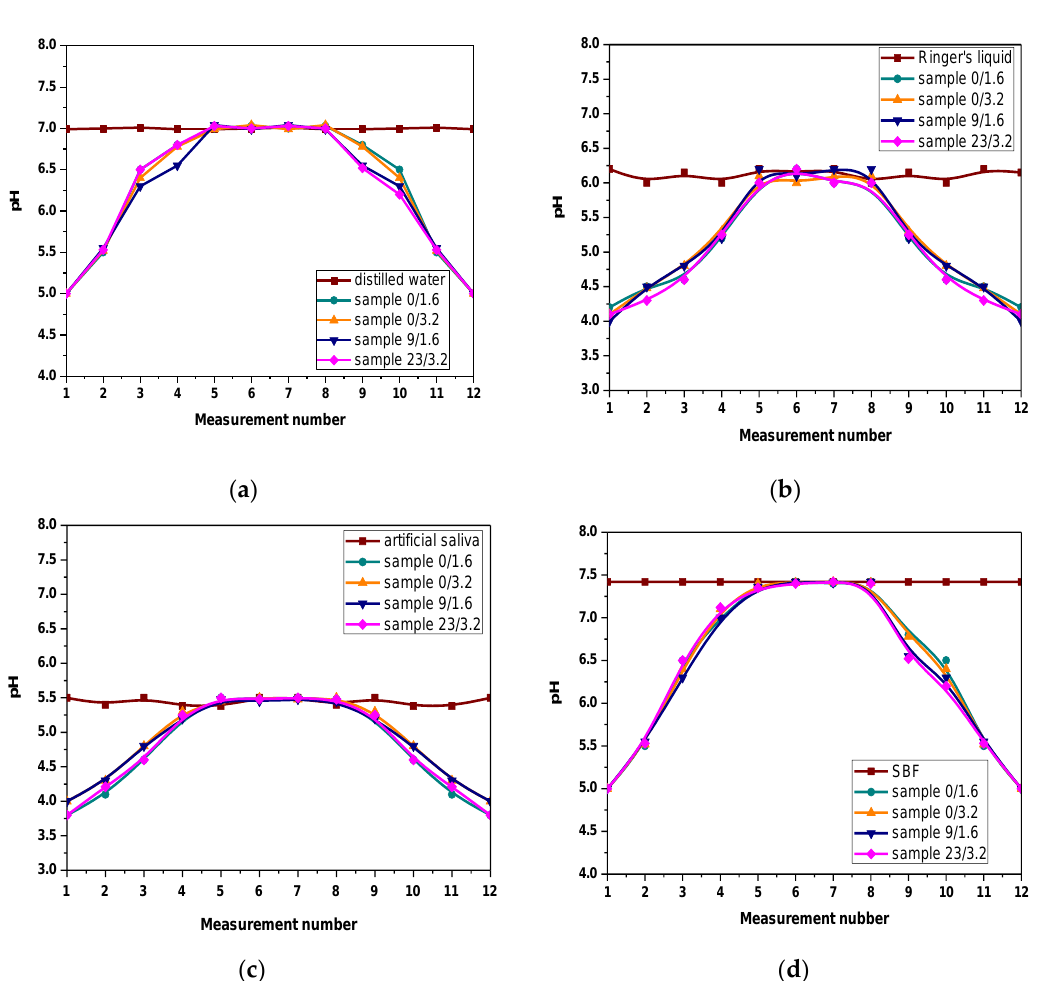
Figure 5. Measured pH values of distilled water ( a ); Ringer liquid ( b ); artificial saliva solution ( c ) and SBF ( d ) during incubation of hydrogel samples in these liquids.